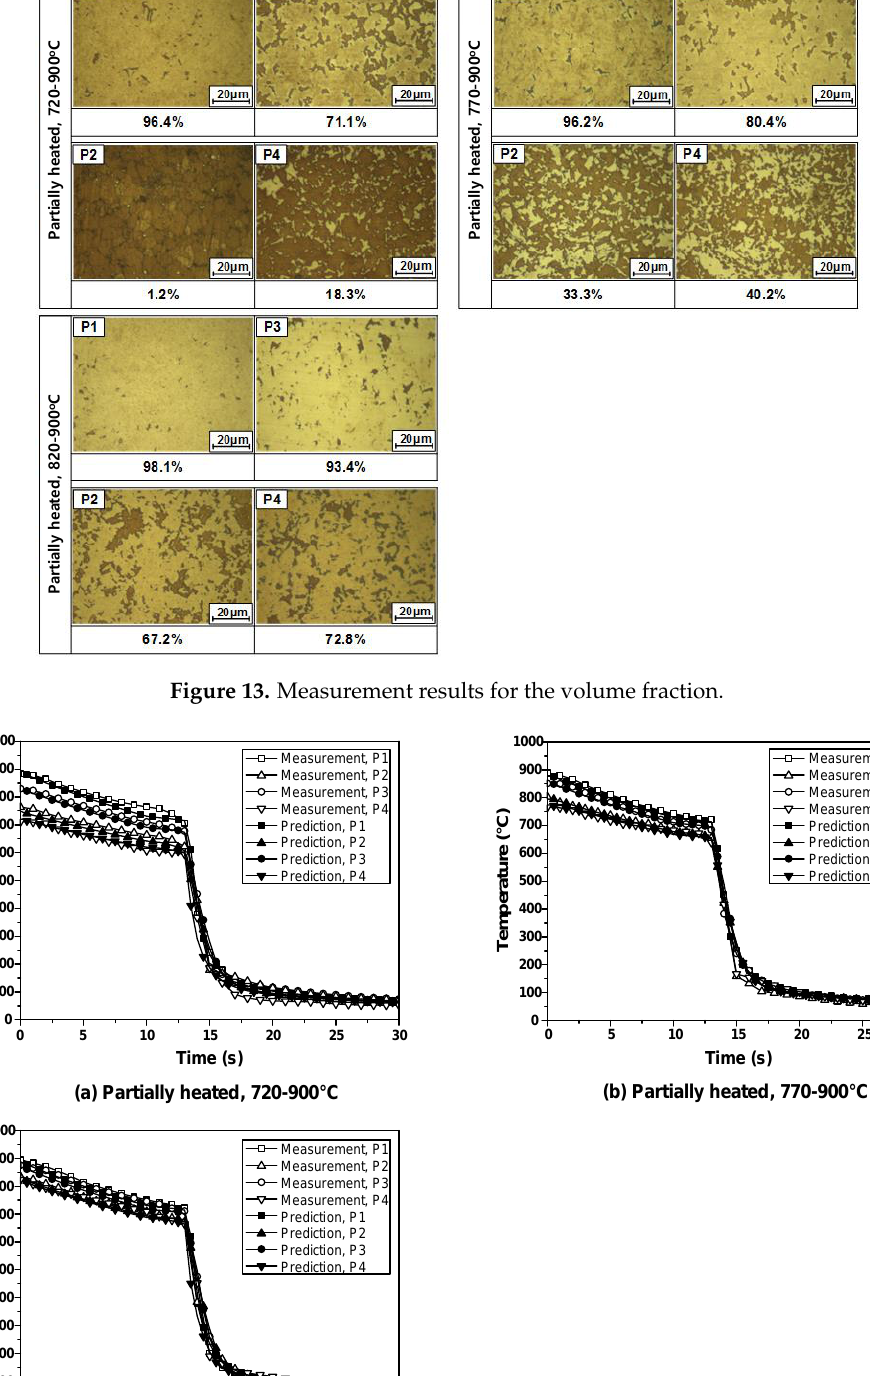
Figure 14. Comparison of the cooling histories between the measurement and prediction.